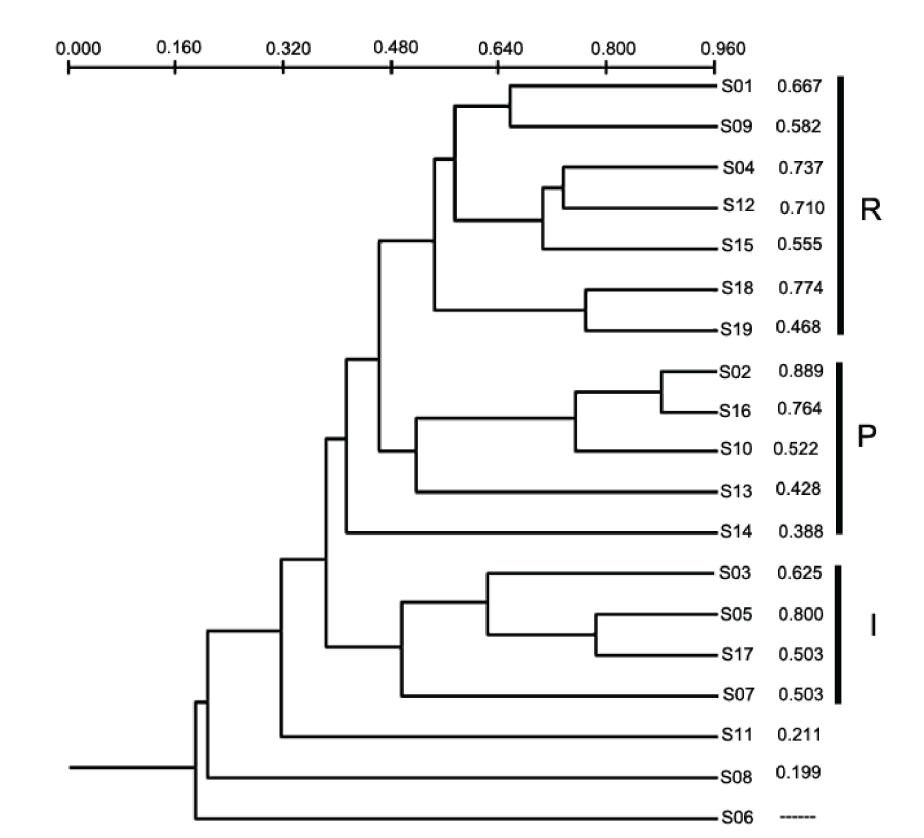
Figure 2. Cluster Analysis (UPGMA method) based on Sorensen’s Index values for 19 streams in Serra da Bocaina Mountain. R – Reference sites; I – Intermediate sites; P – Poor